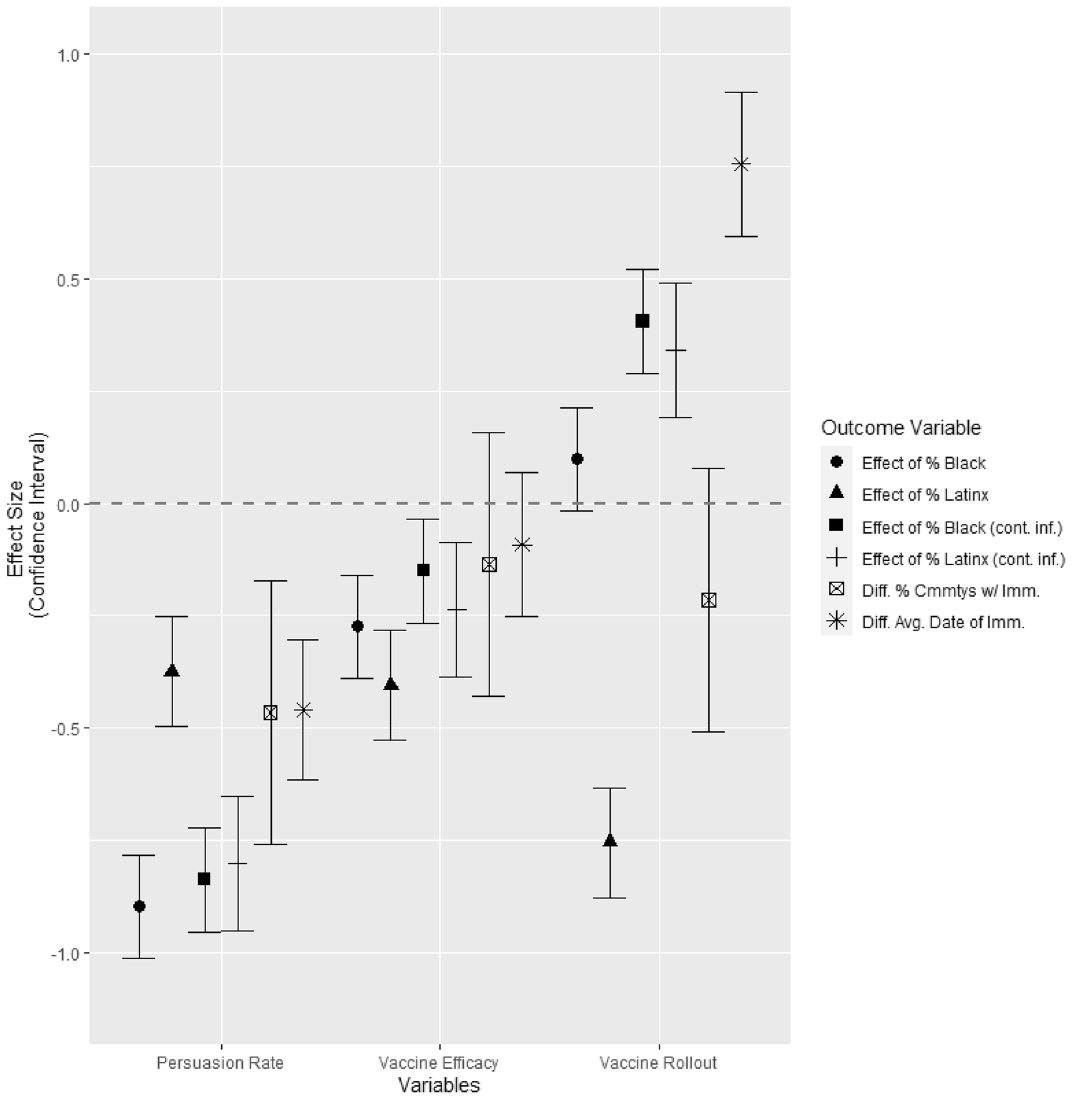
Figure 4. Disparity across simulations. Parameter estimates (unstandardized betas, standard errors, and standardized betas) from regression equations meta-analyzing the indicators of disparity from across simulations with different levels of persuasion, vaccine efficacy, and rollout